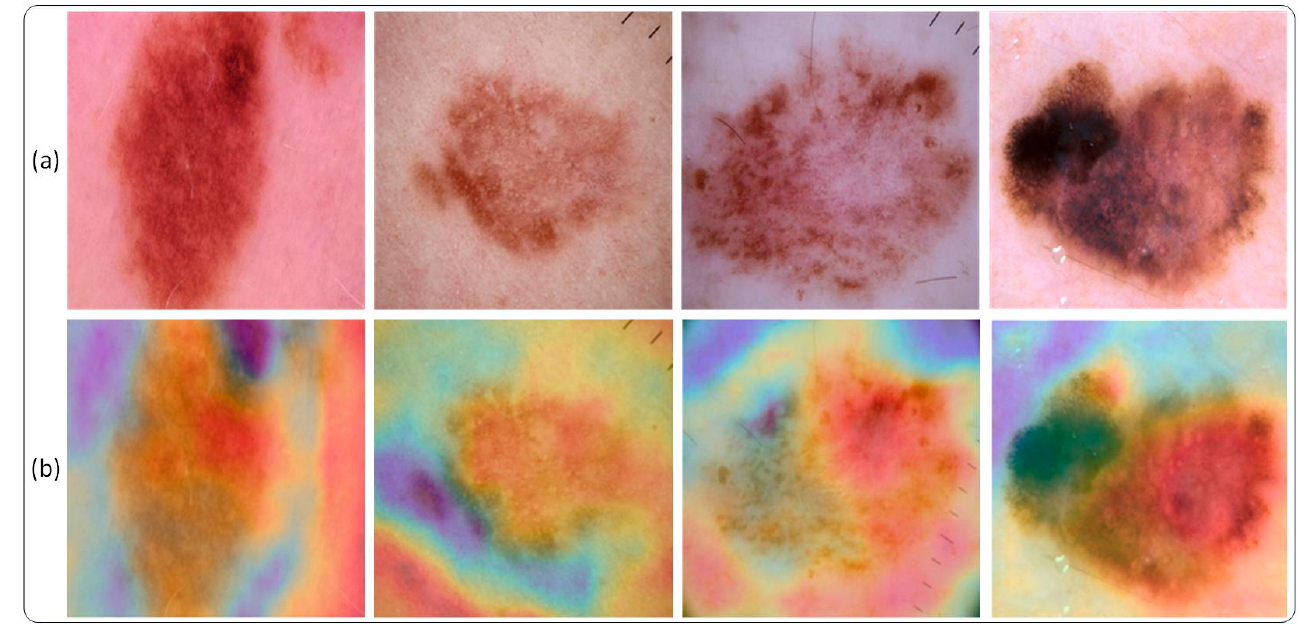
Figure 11. An Illustration of detection of lesion spots using Modified DenseNet201 based on Grad- CAM ( a ) shows the input image and ( b ) depicts the final output of Modified DenseNet201 using Grad-CAM.